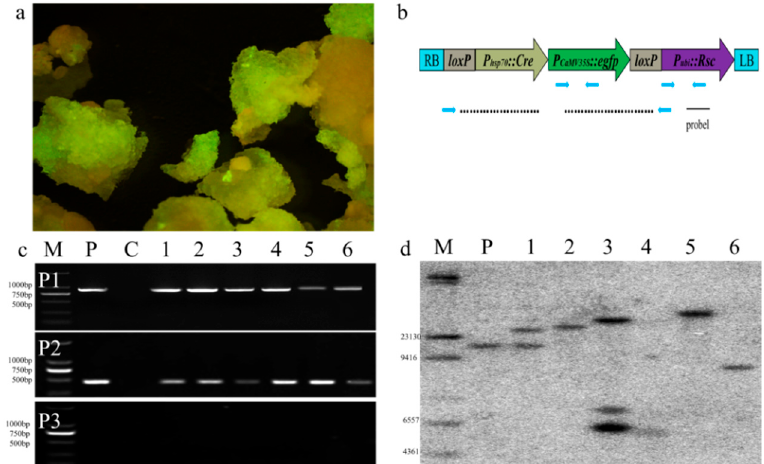
Figure 3. Determination of transformed callus. ( a ) The GFP phenotype of the transformation-positive calli on the DR-46B Dark Reader transilluminator at 3 weeks after infection, the non-fluorescing parts due to the callus being untransformed; ( b ) The PCR monitoring area and probe location in T-DNA organization of pHZM1-Rsc. Specific primer sites frame the T-DNA. P1 detected the selection marker egfp , P2 detected the regulator gene ( Rsc ), and P3 was used to detect the RS after the markers were eliminated. Probe 1 is on the gene Rsc , beside the restriction of endonuclease site Asc I, which is used as a marker for the southern blotting probe. ( c ) PCR analysis of the transformed maize calli. DNA was extracted from six independent transgenic GFP + maize calli; specific primer pairs P1, P2, and P3 were used to detect the selection marker gene egfp , the regulator gene ( Rsc ), and the RS, respectively. M, BM2000 DNA marker; P, positive control P was used as the plasmid DNA; C, negative control; lanes no. 1 - 6, DNA from independent transgenic calli. ( d ) Southern blot analysis of the transferred gene in independent transgenic experiments. M, HindIII DNA Marker; P, positive control P was used as the plasmid DNA; lanes no 1–6, DNA from independent transgenic calli.